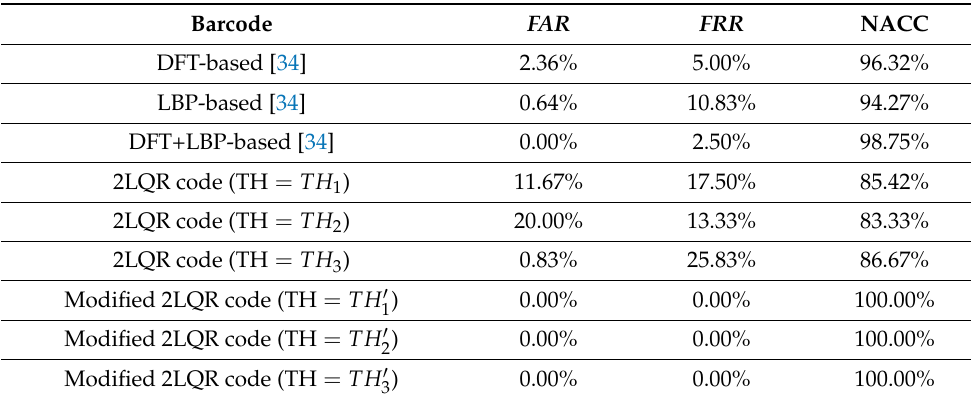
Table 1. Performance of different barcodes in copy